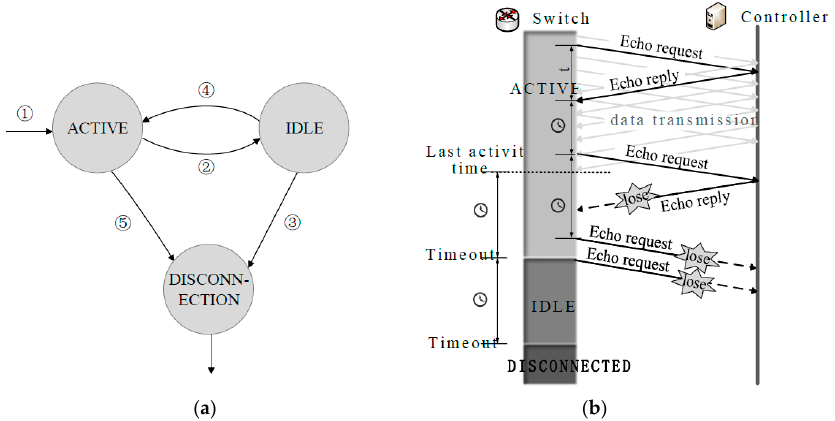
Figure 2. ( a ) State transition; ( b ) tracking connection state in the situation that the link is disconnected. In ACTIVE, because the switch can’t receive any messages or even echo reply messages from